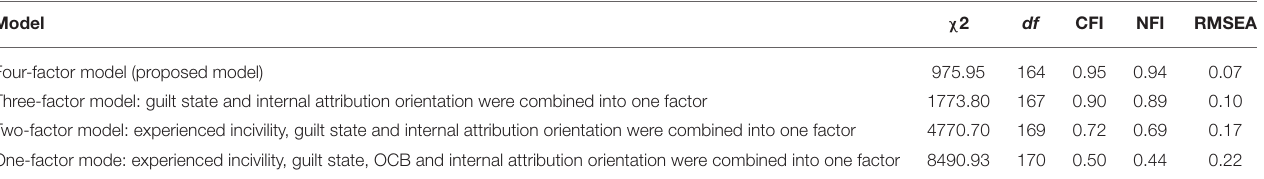
TABLE 2 | Results of confirmatory factor analyses. Model Four-factor model (proposed